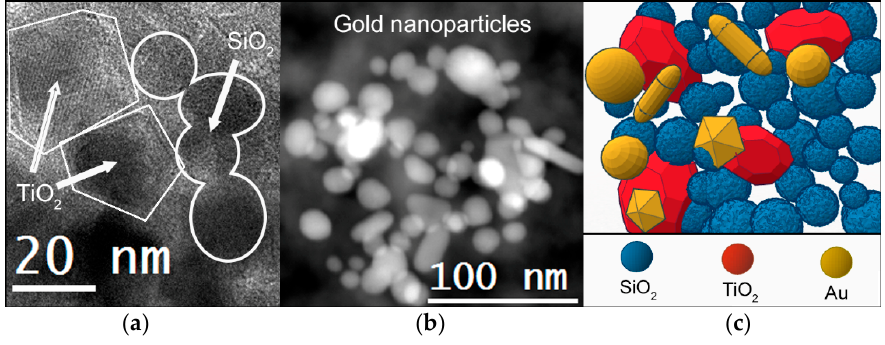
Figure 6. ( a ) HRTEM image of the xerogels under study; ( b ) HAADF image of detail of AuNPs into the xerogels and ( c ) model of nanostructure of photocatalyst built from these images.